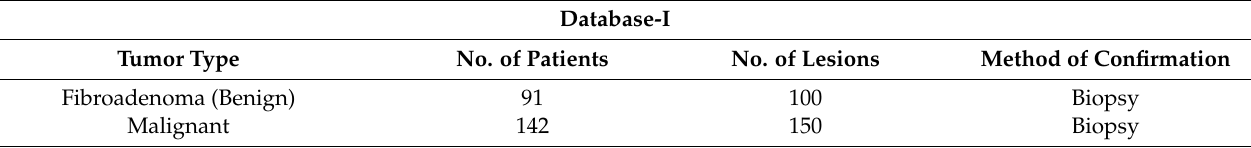
Table 1. Patient data summary.